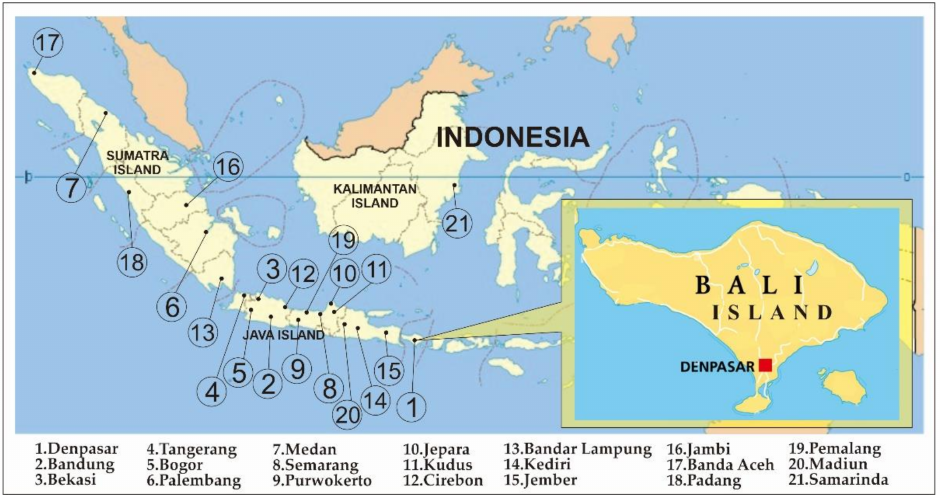
Figure 1. Red box for motorcycles in 21 cities in